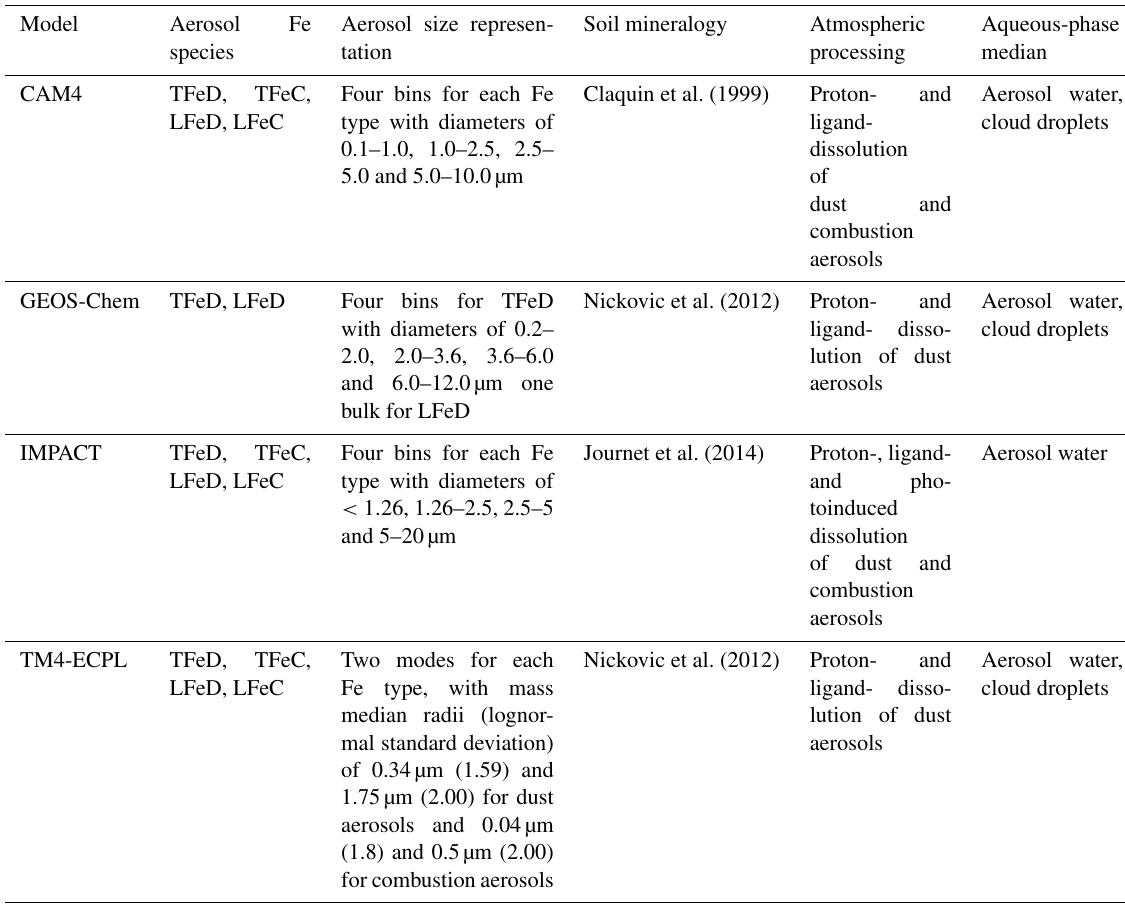
Table 2. Iron representation in the models: TFeD – total Fe in mineral dust, TFeC – total Fe in combustion aerosols, LFeD – labile Fe in mineral dust, and LFeC – labile Fe in combustion aerosols.